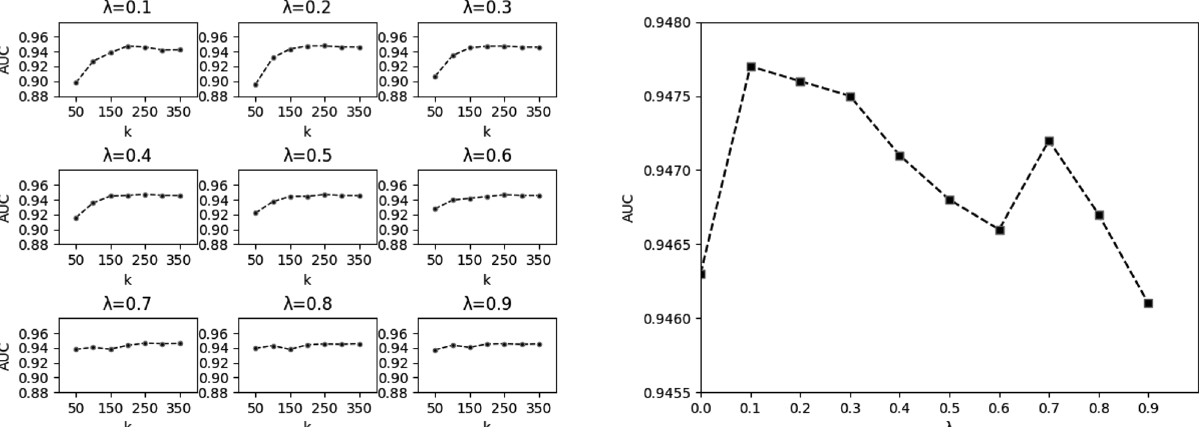
Figure 4. Performance fluctuations of the model at different values of k and λ (Left) and trend of model optimal performance with λ (Right).